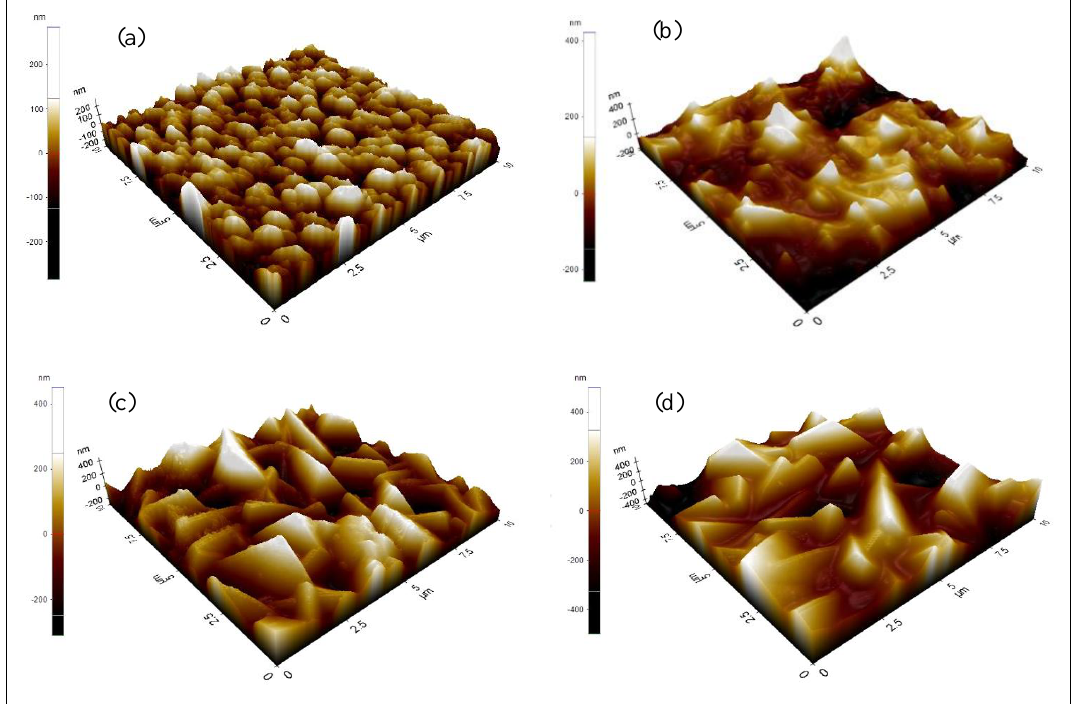
Figure 8. AFM images of the Cu 2 O films obtained at different electrodeposition time of (a) 30, (b) 60, (c) 90 and (d)